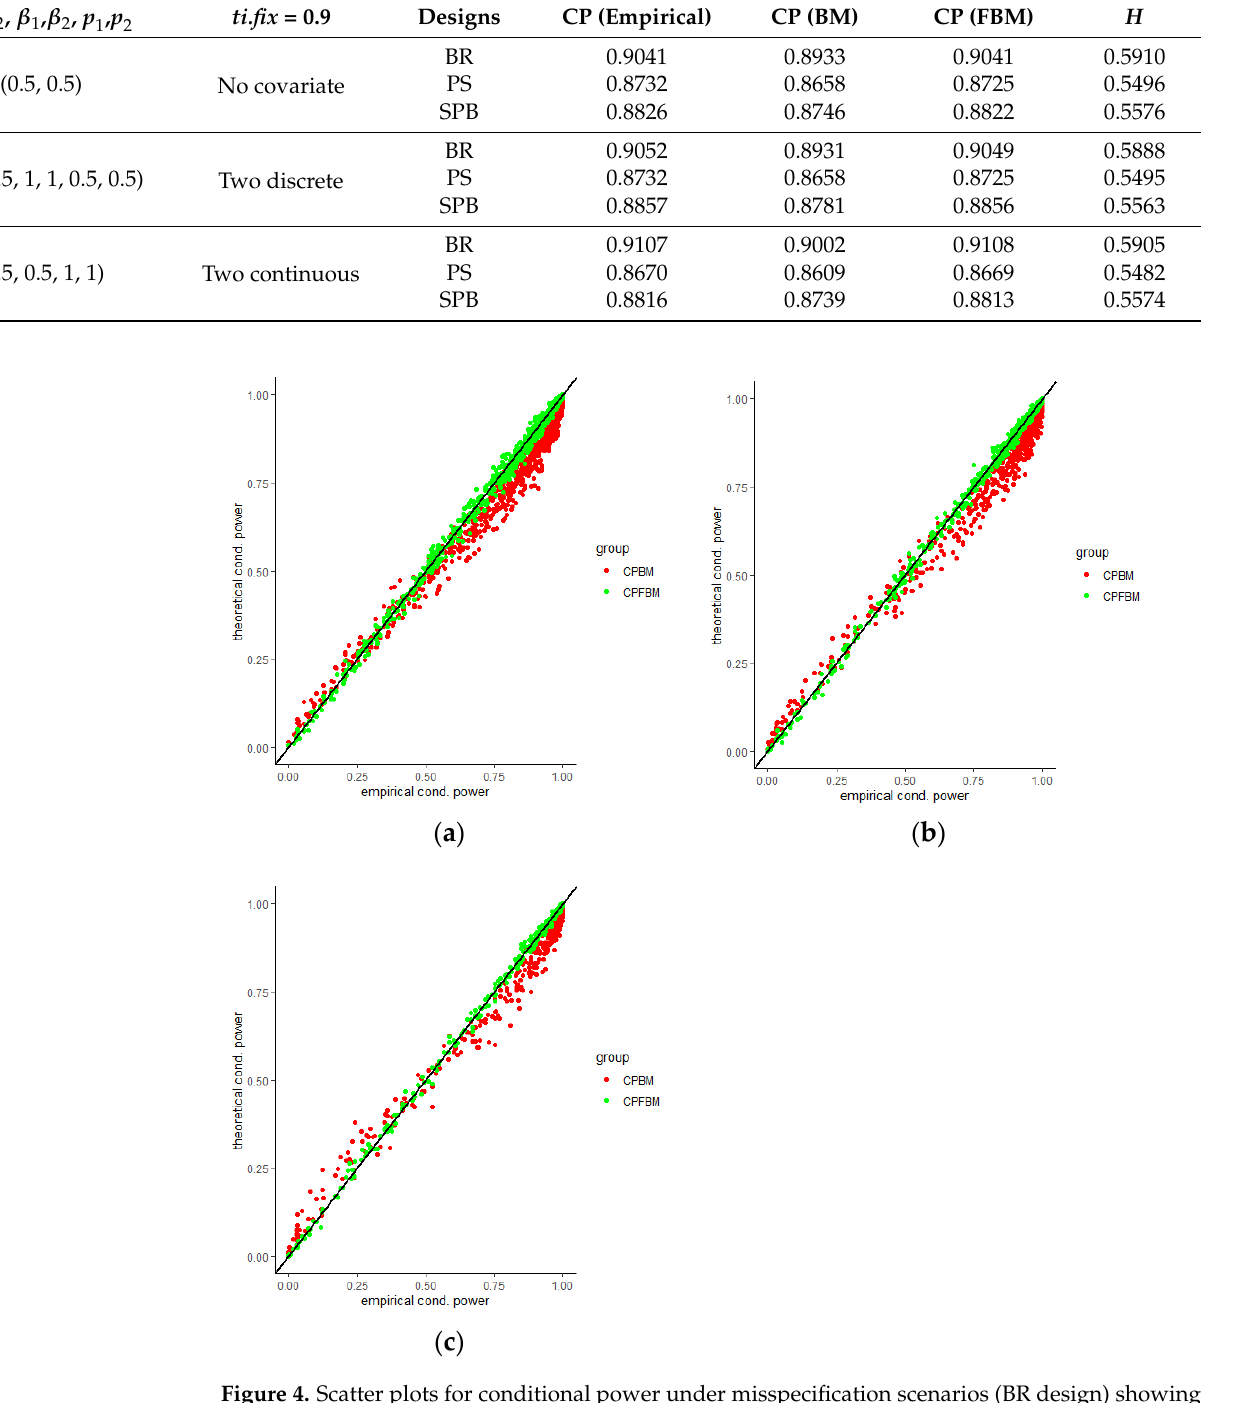
Figure 4. Scatter plots for conditional power under misspecification scenarios (BR design) showing two continuous covariates with different ti.fix time points: ( a ) ti.fix = 0.7; ( b ) ti.fix = 0.8; ( c ) ti.fix = 0.9.